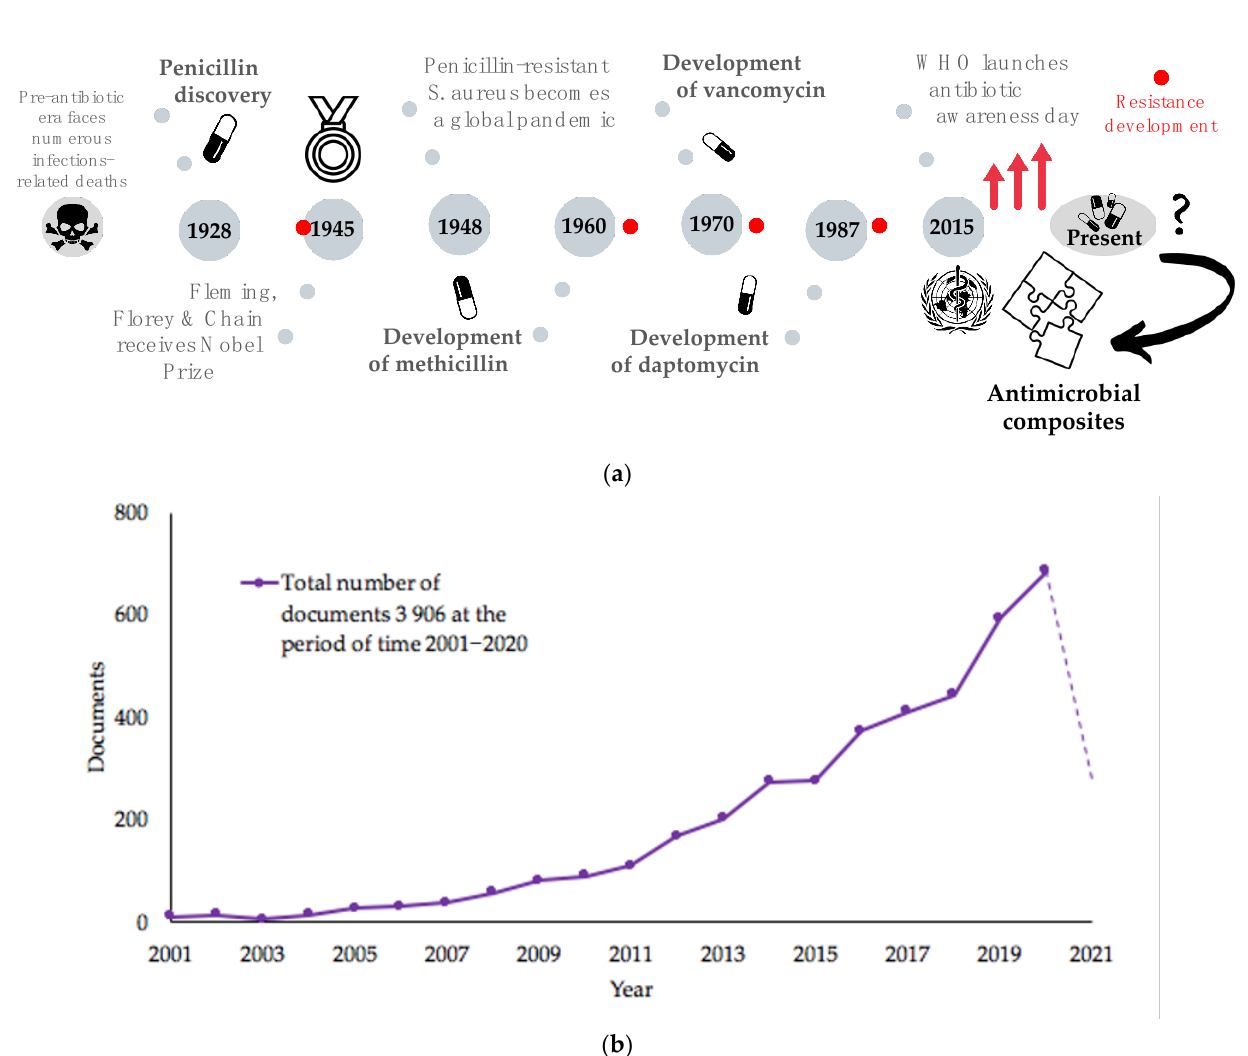
Figure 1. ( a ) Milestones of the antimicrobial medicine and antimicrobial resistance (AMR) development starting from the discovery of penicillin in 1928 and until the present time, where application of antimicrobial composites might work as a missing puzzle in the fight with AMR. ( b ) Statistics on publications in English (articles and book chapters) using keywords “composites” and “antimicrobial”: total number of documents reached 3906 during years of 2001–2020 and is still growing. Scopus. Available online (https://www.scopus.com accessed on 23d of April 2021).